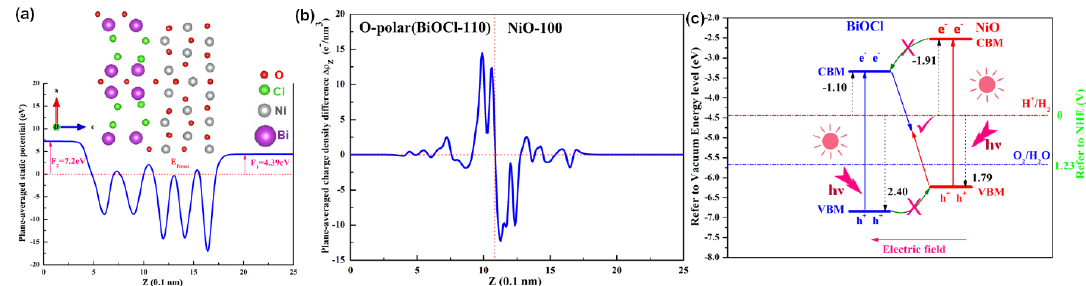
Figure 4. First-principles calculations for the plane-averaged electrostatic potential energy profile ( a ), the charge density difference for the NiO(100)-O(BiClO-110) heterostructure ( b ), and schematic illustration of the band alignment and the photogenerated charge carrier transfer process in Z-scheme mode for the NiO@BiOCl heterojunction ( c ). CBM, minimum conduction band; VBM, maximum valence band.